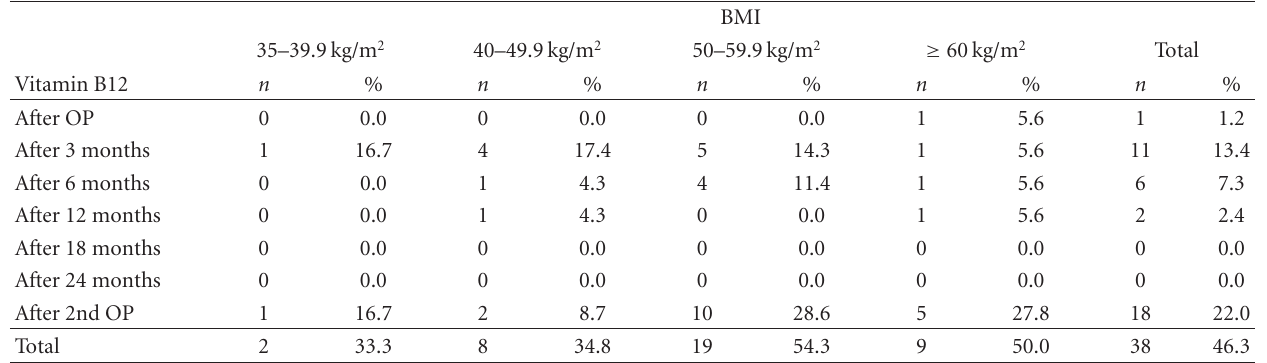
Table 9: Necessity of vitamin B12 supplementation during the follow-up